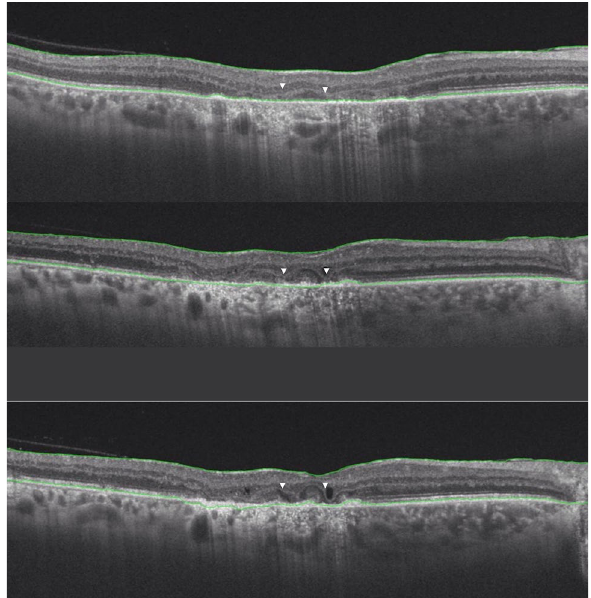
Figure 3. A representative figure of a patient with tubercular serpiginous-like choroiditis showing foveal optical coherence tomography (OCT) B-scans at three visits. The foveal OCT B-scan at first visit (top panel) shows a near-normal hyper-reflective outer plexiform layer (OPL). The foveal OCT B-scan at second visit (3 months) shows thinning of the OPL, which has been thrown into undulations (middle panel). The OCT B-scan at third visit (6 months) (bottom panel) shows significant thinning and atrophy, resulting in formation of a middle limiting membrane (white arrowheads).